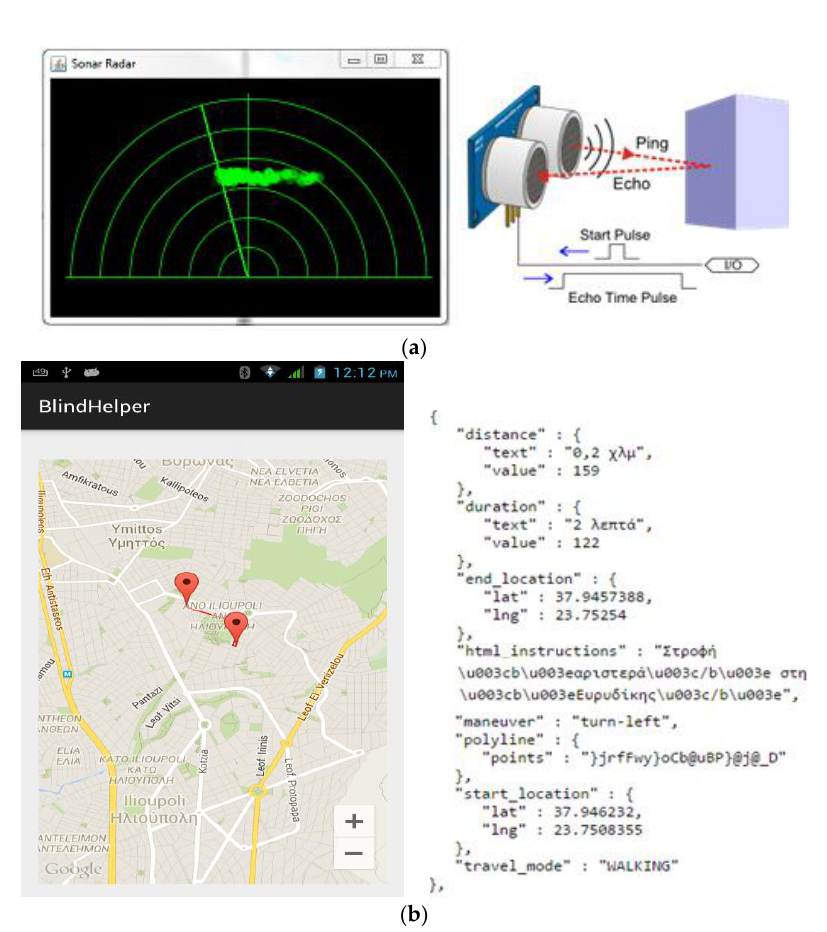
Figure 1. ( a ) Ultrasonic ranging module and radar view operation; ( b ) Android voice-instructed route navigation